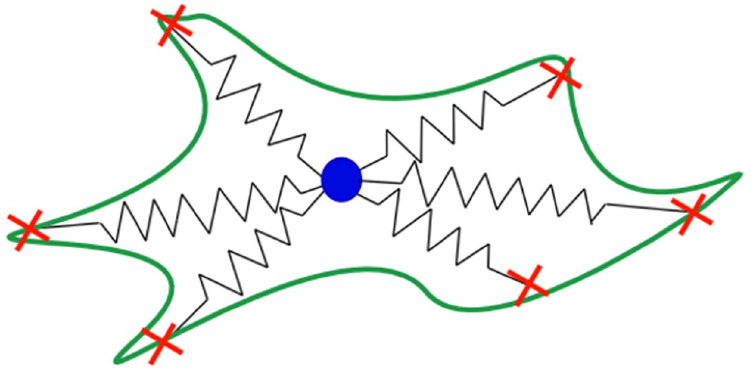
Fig 1. Cell model. This figure from Dallon, et.al. [21] depicts the way the cell is being modeled mathematically. The cell is a center location (nucleus) with attached springs. The other ends of the springs correspond to the different FAs that are attached to the extracellular matrix at